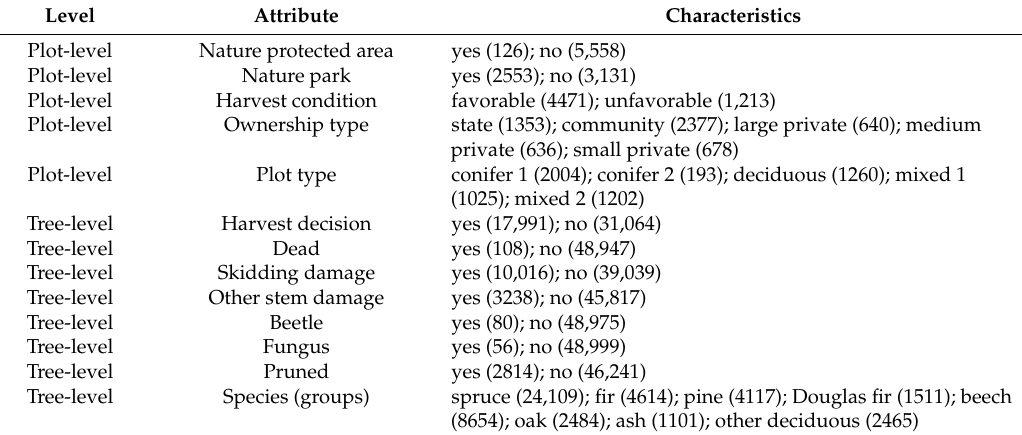
Table A2. Characteristics of discrete training set variables (5684 plots with 49,055 sample trees).